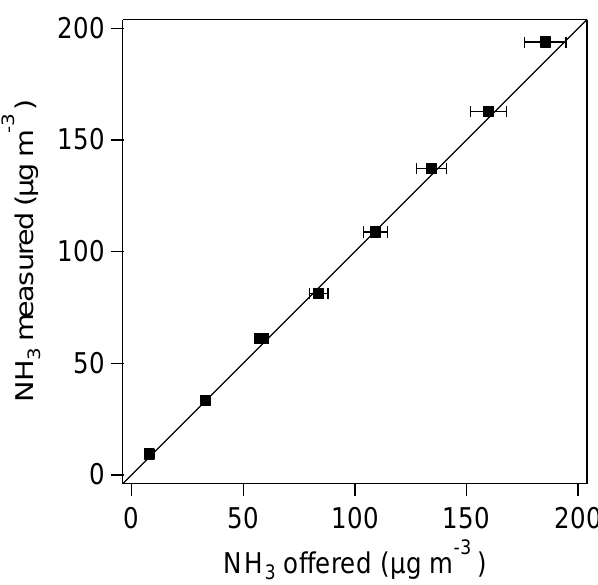
Fig. 9. Results of the linearity test for the RIVM DOAS instrument. Horizontal error bars indicate estimated errors of 5% in the NH 3 concentrations offered. Vertical error bars indicate 1- σ errors in the measured NH 3 concentrations. If the error bars are not visible they are smaller than the symbol plotted.